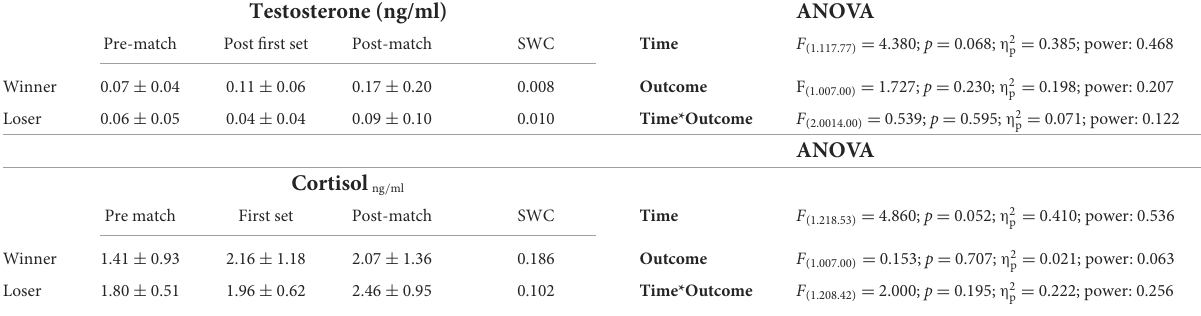
TABLE 2 Comparison of hormonal concentration between winners and losers.